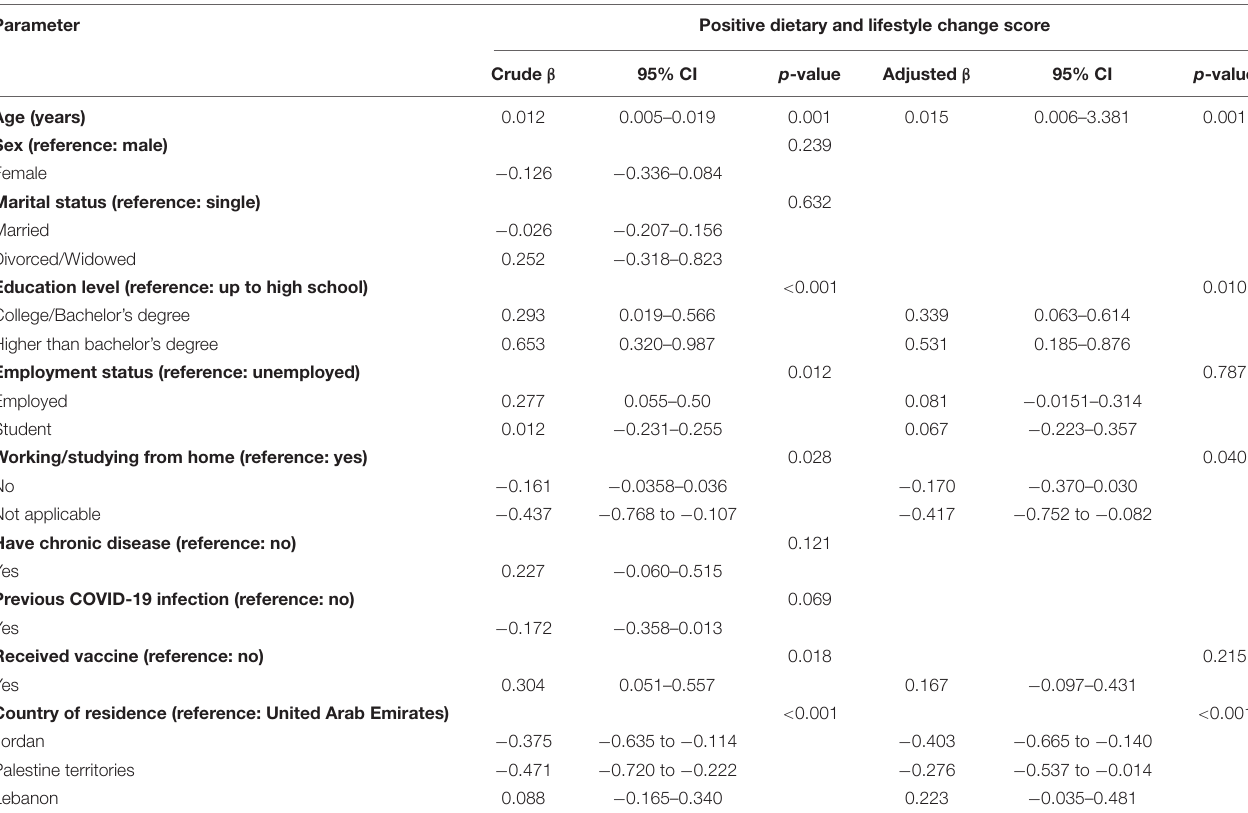
TABLE 5 | Association between positive dietary and lifestyle change score and sociodemographic characteristics in the study population ( n = 2259). Parameter Positive dietary and lifestyle change score Crude